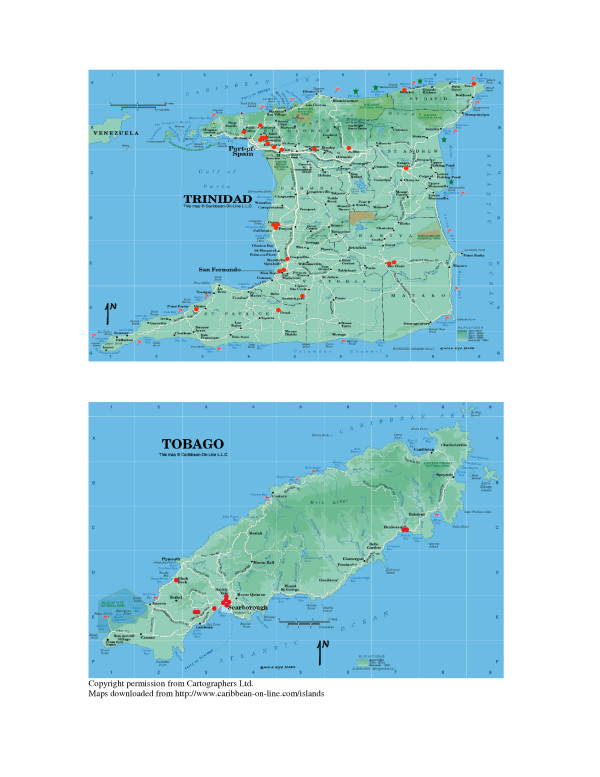
Maps of Trinidad & Tobago showing locations of schools (red dots) that participated in the survey.